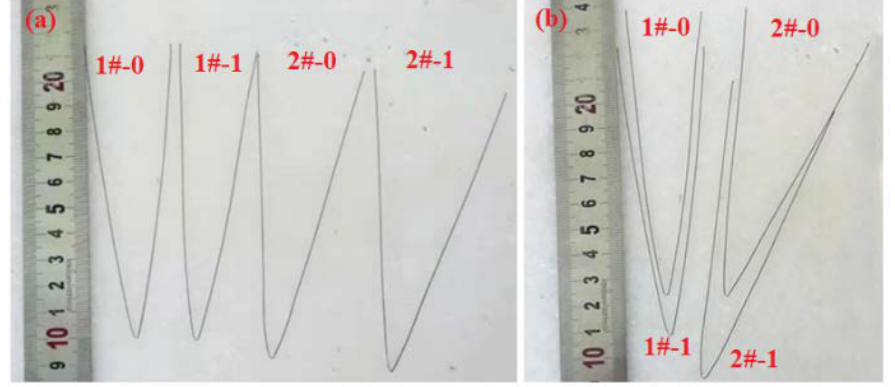
Figure 1. Test samples of Φ 0.39 mm tungsten wires for sag value test ( a ) and recrystallization behavior test ( b ).